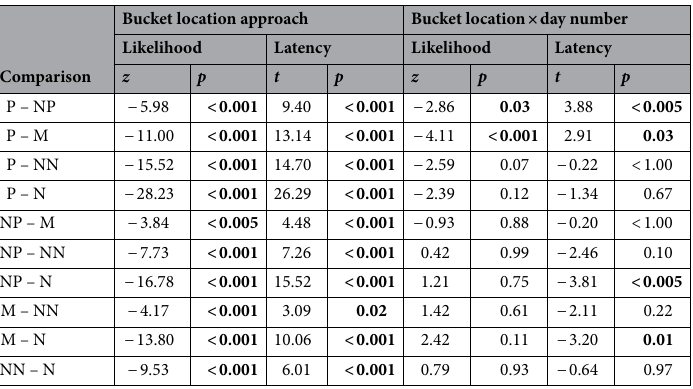
Table 2. Pairwise comparisons of the likelihood and latency to approach each bucket location, and for the bucket location × day number interaction. Bold p values are